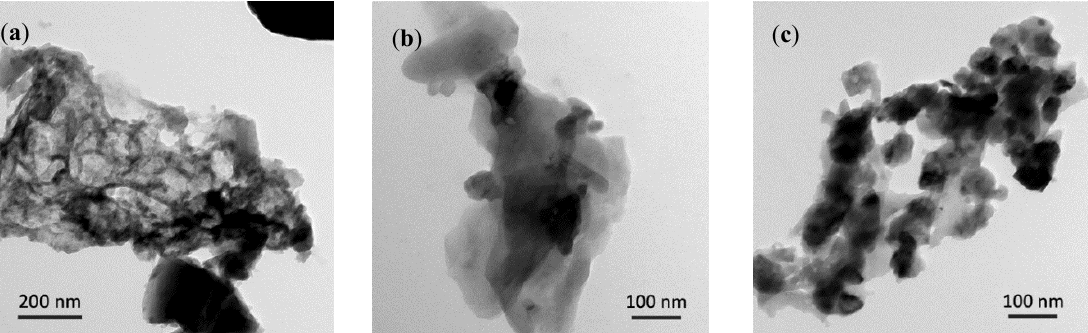
3 N 4 @Cu, and ( c ) Si 3 N 4 @Si@Cu films.